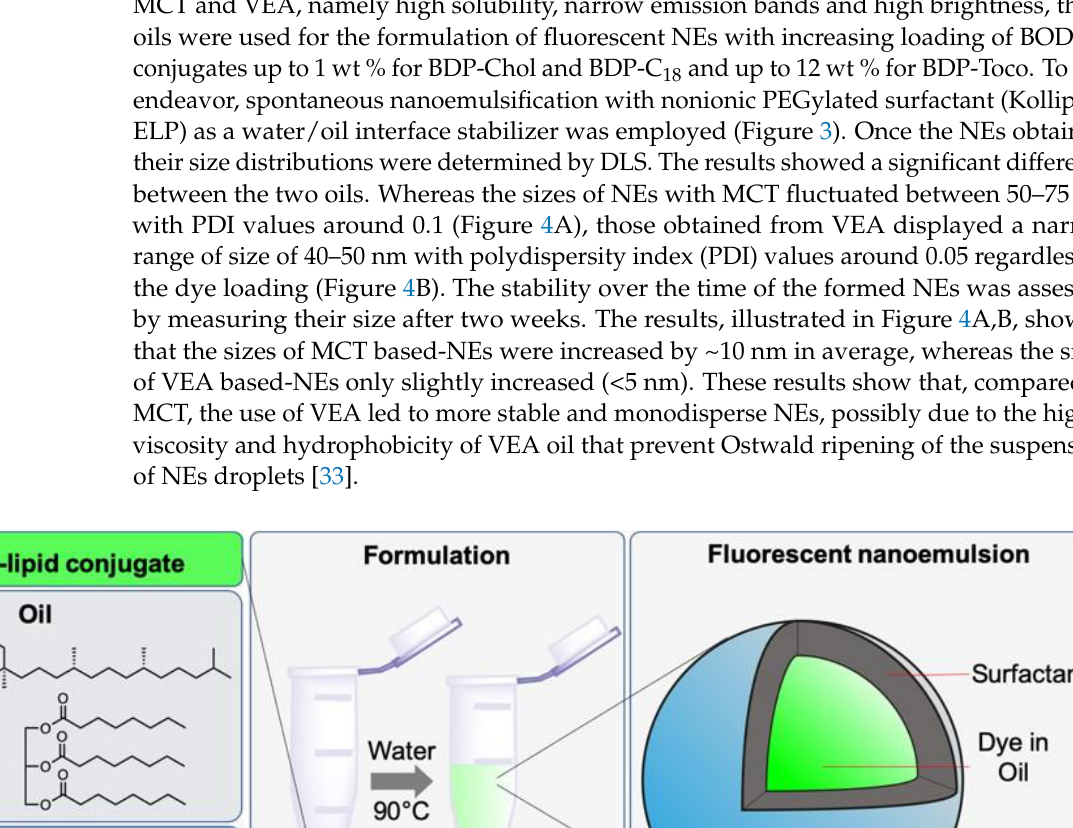
Table 2. Solubility of three BODIPY conjugates in oils (at R.T.).